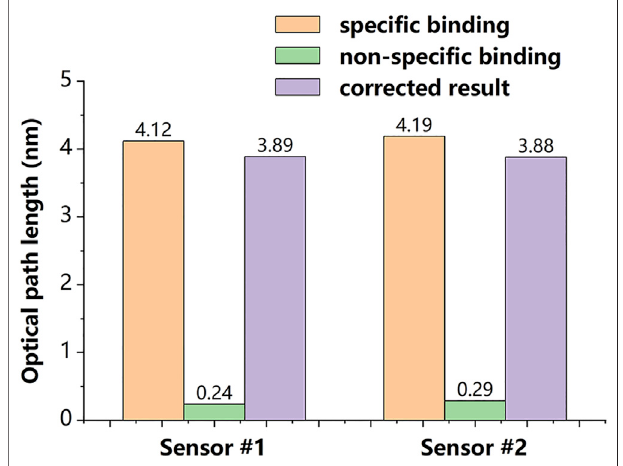
FIGURE7| Relationshipbetweentheamount ofbindingand